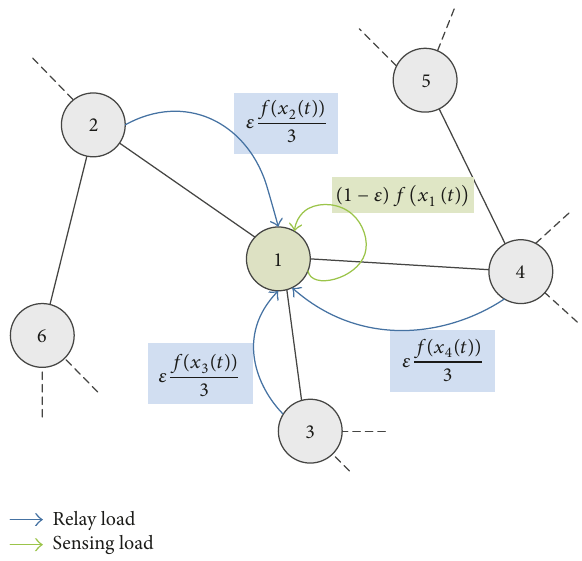
Figure 1: An example of load